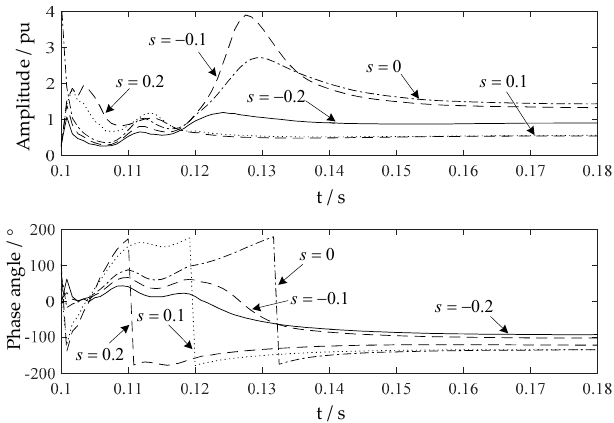
 Z in Case 2. Figure 15. Characteristic simulation results of Z ∗ in Case w + 